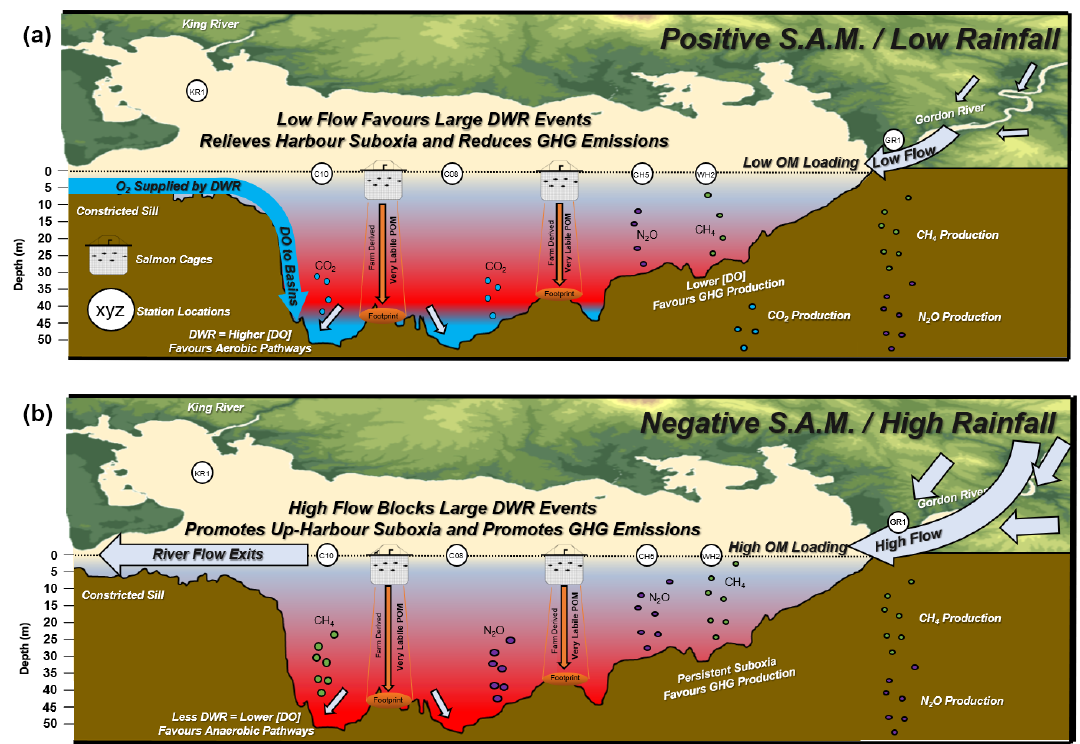
Figure 10. Conceptualisation of the role of freshwater inputs on the distribution of DO and potential for GHG production in the harbour. (a) Harbour DO and GHG during periods of low rainfall (or positive SAM index) promoting DWR. (b) High rainfall (negative SAM index) blocks DWR and promotes the spread of suboxia and thus GHG